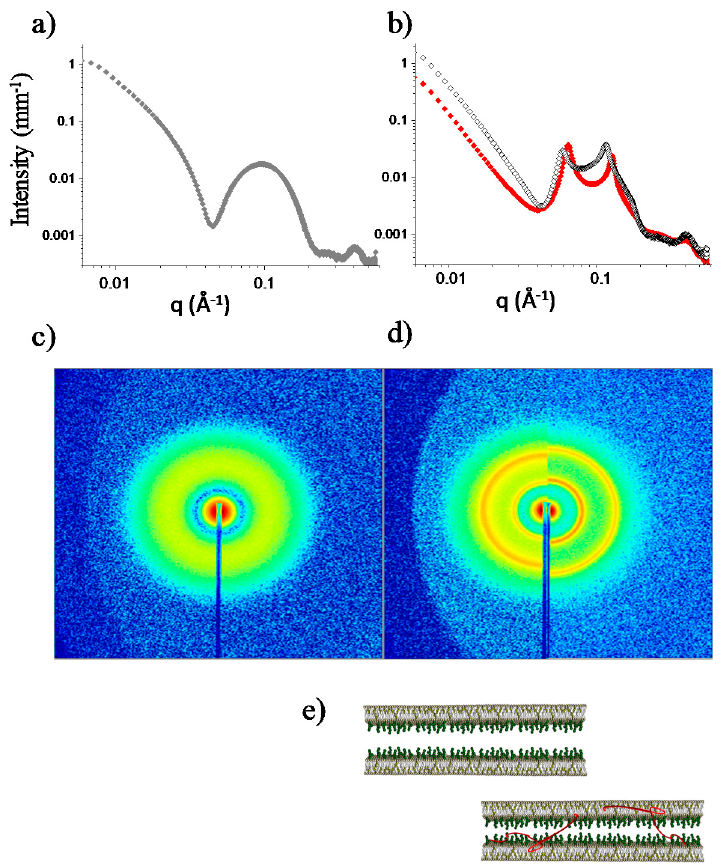
Figure 6. A β monomers intermediation between facing raft-mime bilayers. SAXS spectra and 2D images of raft-mime unilamellar vesicles (LUVs) reshaping upon osmotic stress. ( a , c ) before stress; ( b , d ) after stress with A β mon -free bu ff er (black open symbols in panel ( b ), and right image in panel ( d )) and with bu ff er solution containing A β mon(1–42) (0.2% mole fraction to the lipid) (red symbols in panel ( b ), left image in panel ( d )). The rising of Bragg peaks, superimposed to the bilayer form factor, indicated the transition from unilamellar to multilayered vesicles. Peaks position was related to the characteristic inter-lamellar spacing of the raft-mime liposome in the absence and in the presence of A β mon . ( e ) Pictorial sketch of possible coordination between facing raft-mime membranes induced by nascent A β .